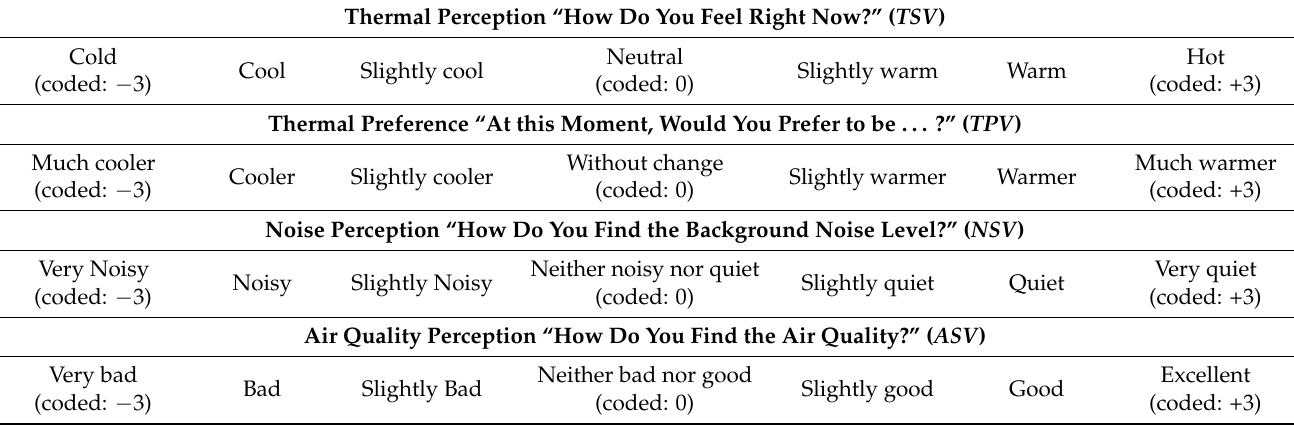
Table 1. Sampled questions related to the investigated variables from the weekly survey questionnaires. Thermal Perception “How Do You Feel Right Now?” ( TSV